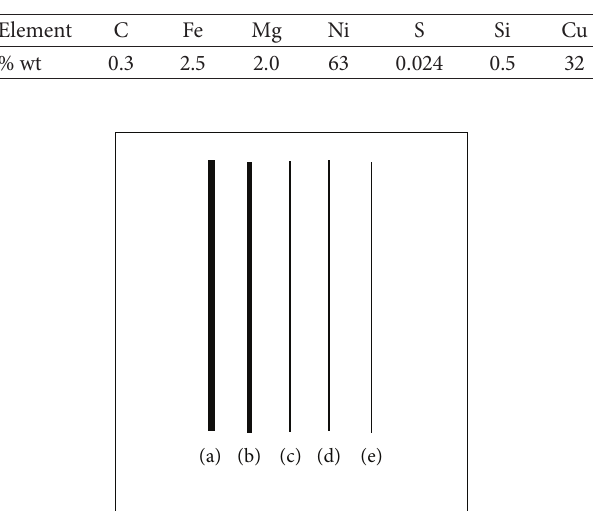
Figure 1: Phototool of different slot widths: (a) 250 𝜇 m; (b) 200 𝜇 m; (c) 150 𝜇 m; (d) 100 𝜇 m; and (e) 60 𝜇